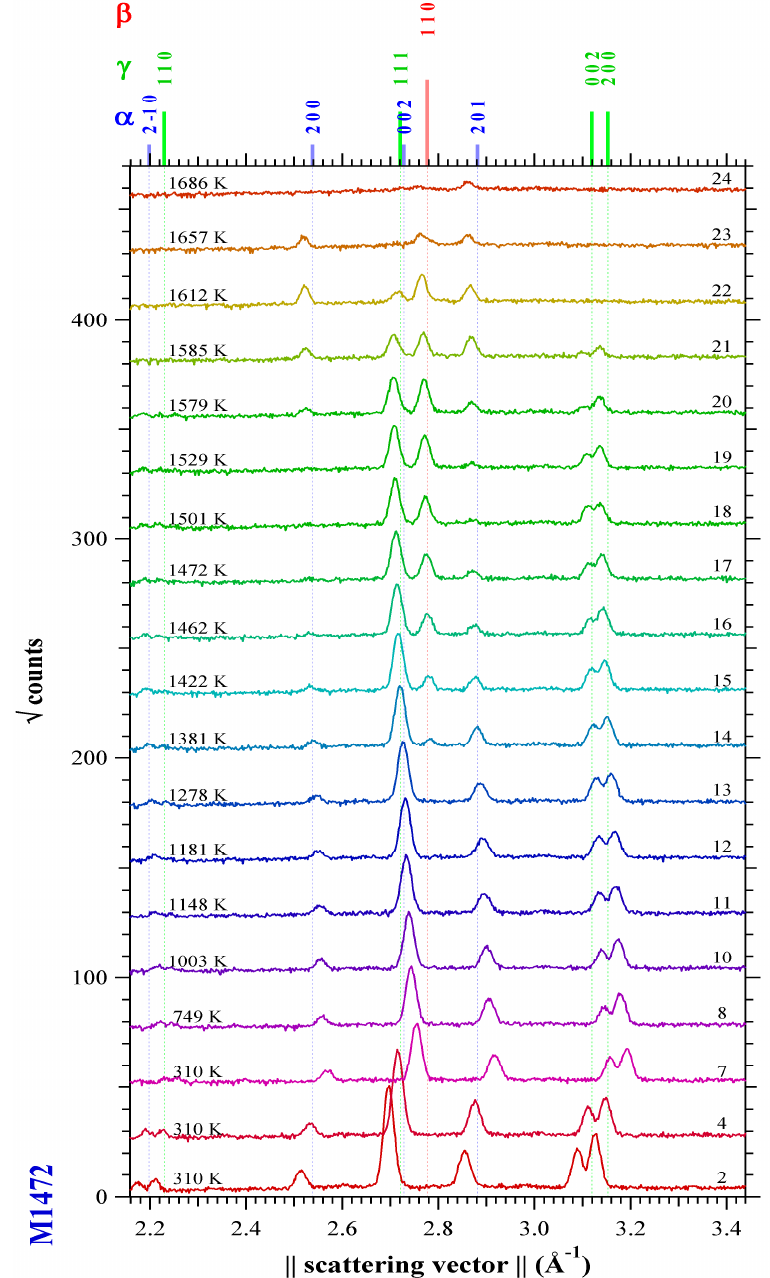
Figure 7. Zoomed compilation of all diffraction patterns upon pressurizing at room temperature (first 3) and on stepwise temperature ramping at the maximal achieved pressure. Temperature tags are given to the left, serial numbers to the right.